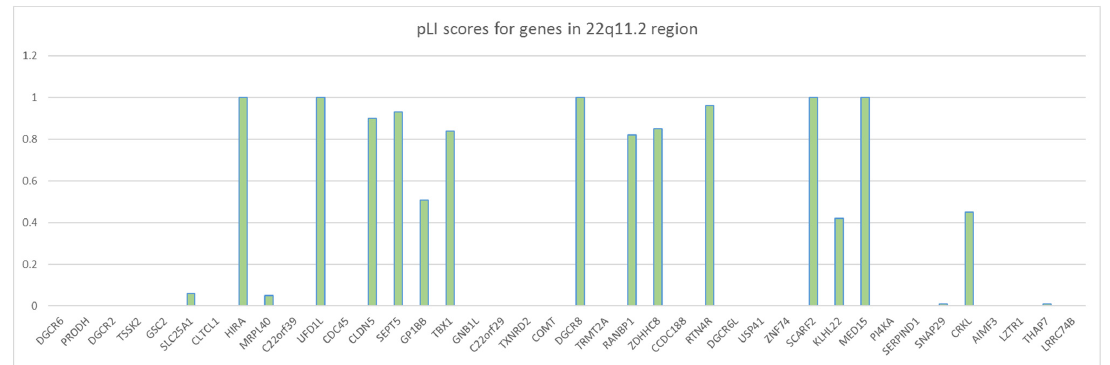
Figure 2. pLI scores for genes in the 22q11.2 region. The arrangement of genes according to their order in the 22q11.2 region. pLI score values were obtained from the gnomAD browser [37] .